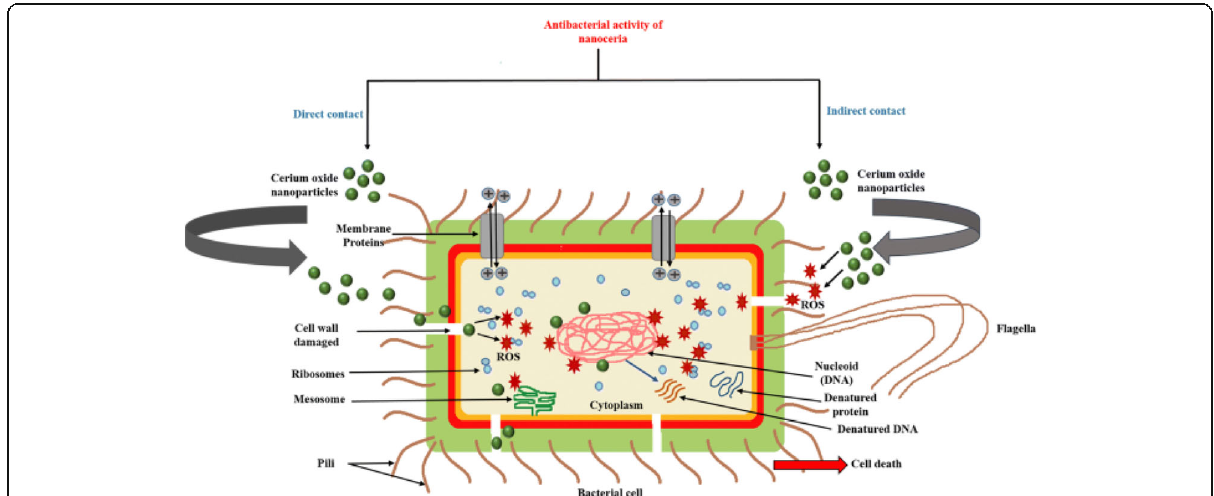
Fig. 5 Antibacterial activity mechanism of cerium oxide NPs. a Direct contact. b Indirect contact. Reproduced from ref. [18] with permission from Springer